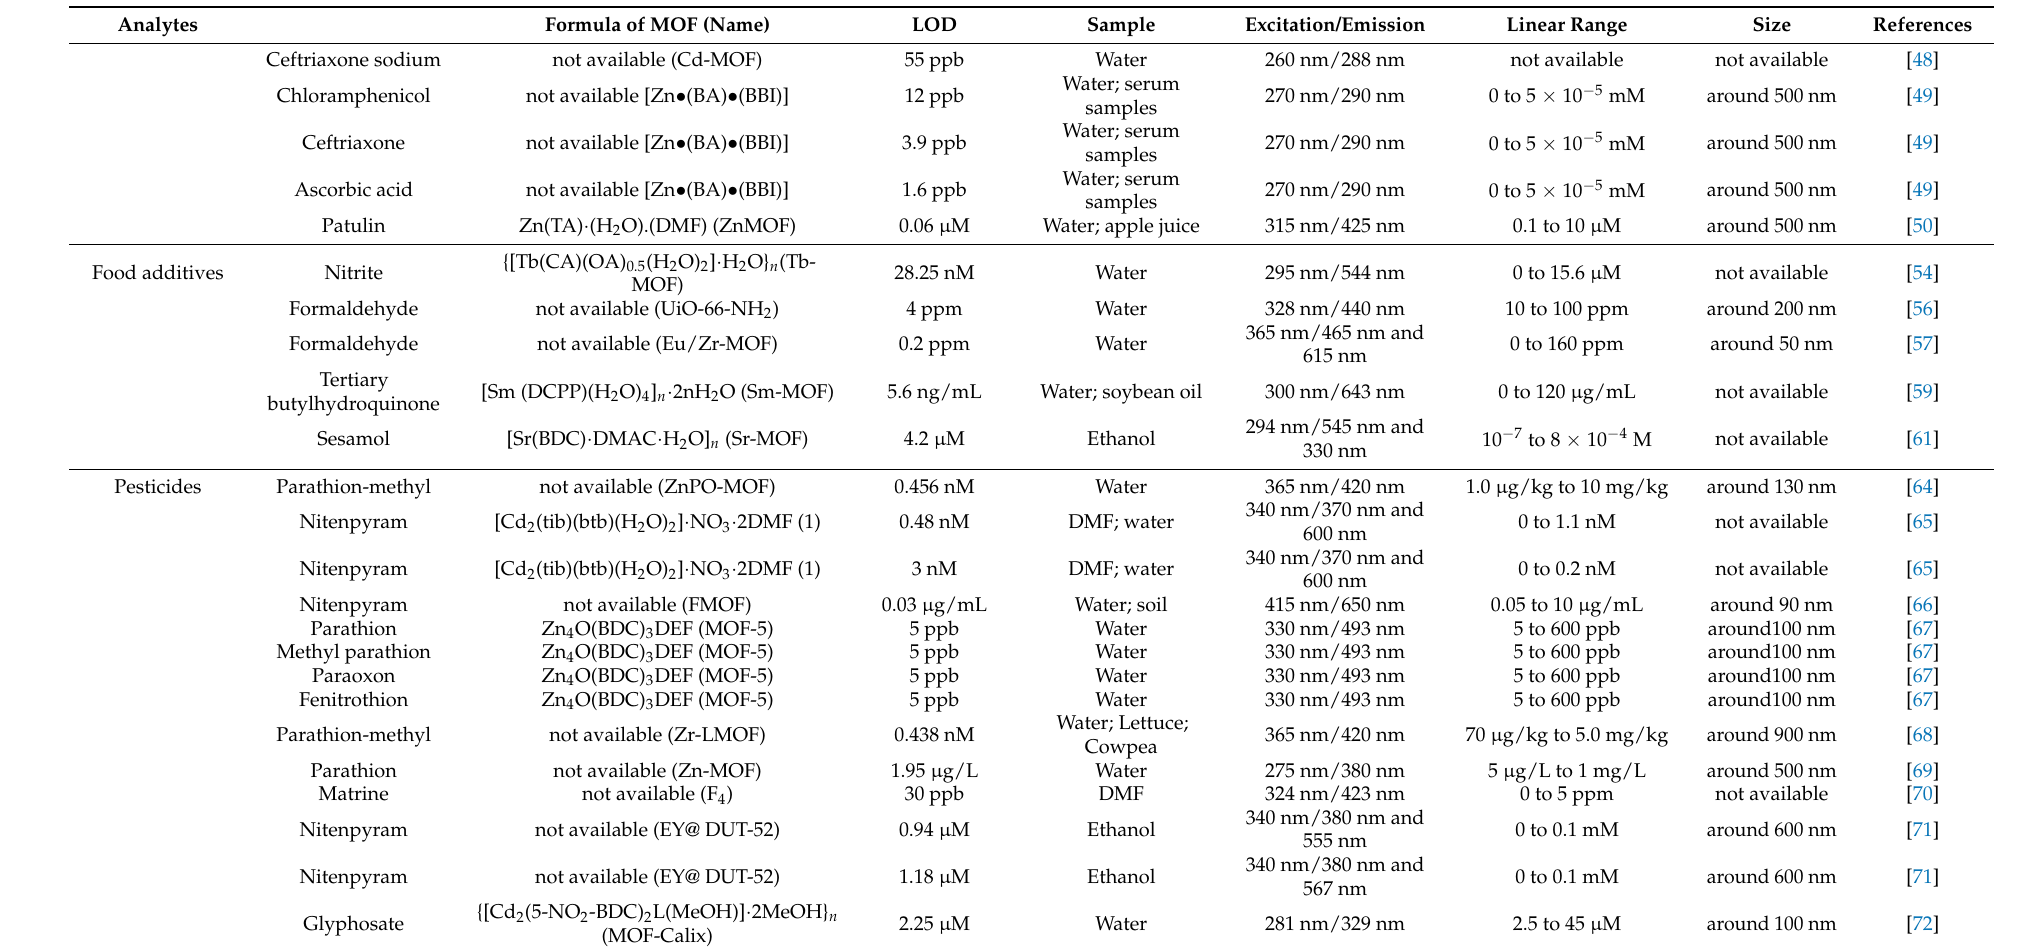
Table 2. A summary of representative examples of NMOFs for food